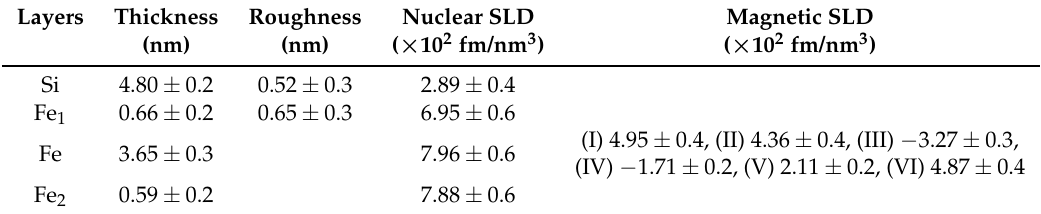
Table 1. Structural parameters of the sample given by the fitting to the polarized neutron reflectivities. Fe 1 and Fe 2 : “Magnetically-dead” layers just above and below the middle Fe layer. SLD, scattering length